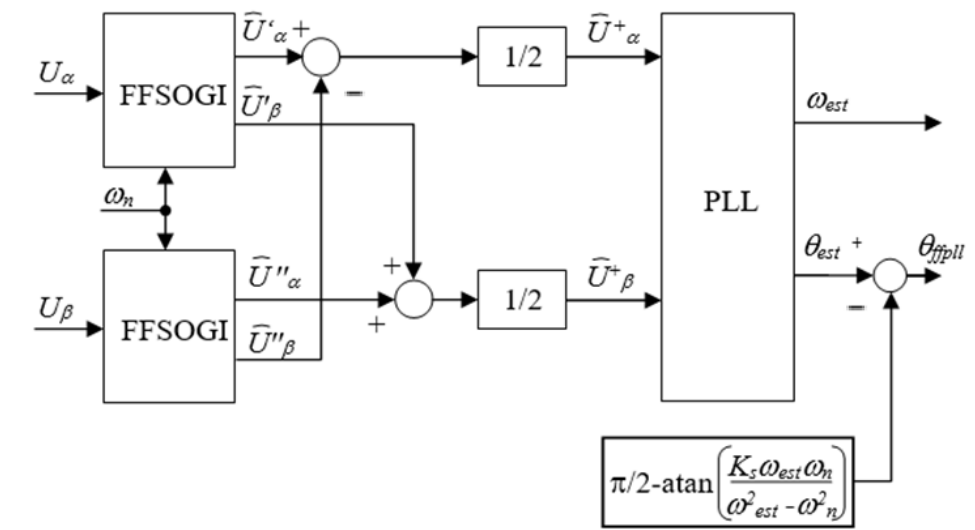
Figure 8. The positive sequence separation based FFPLL.